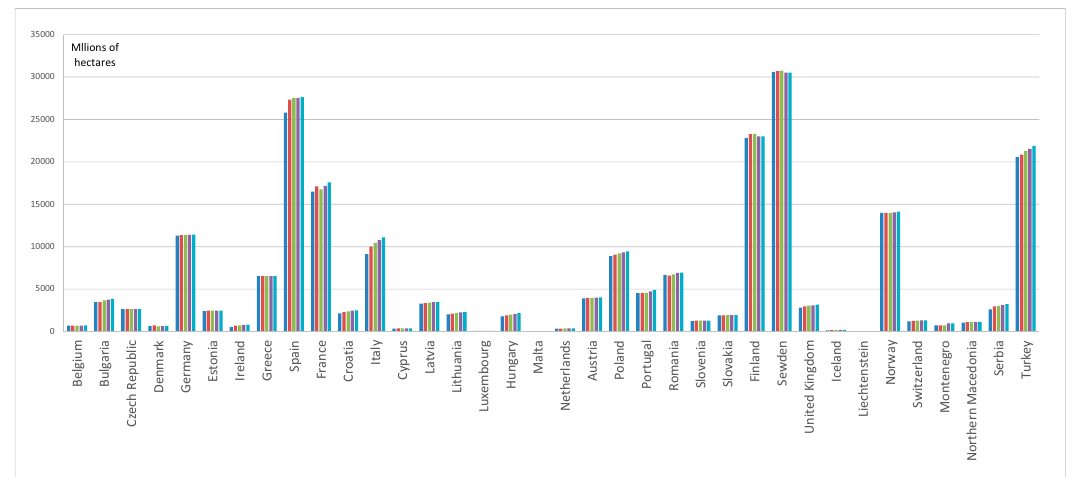
Figure 2. Evolution of forest area in European countries for the periods 1990, 2000, 2005, 2010, and 2015 (adapted from [42]).